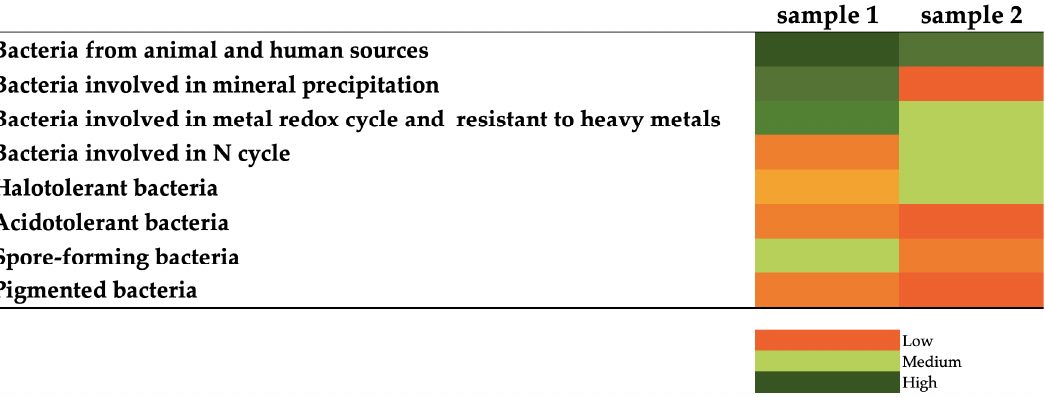
Figure 6. Metagenomic data of rock samples to ( a ) Phylum level; ( b ) Genus level with a relative abundance of higher than 1% in the samples.